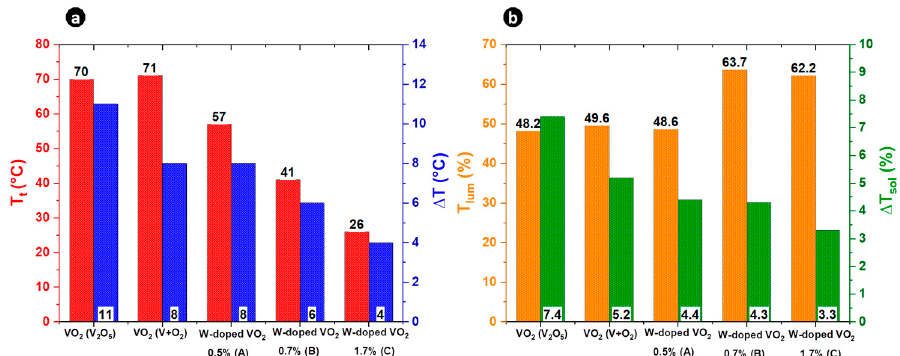
Figure 2. ( a ) Phase transition temperature (red) and hysteresis width (blue) for undoped and W- doped VO 2 thin films. ( b ) The corresponding luminous transmittance (T lum , orange) and the solar modulation ability ( ∆ T sol , in green) values.